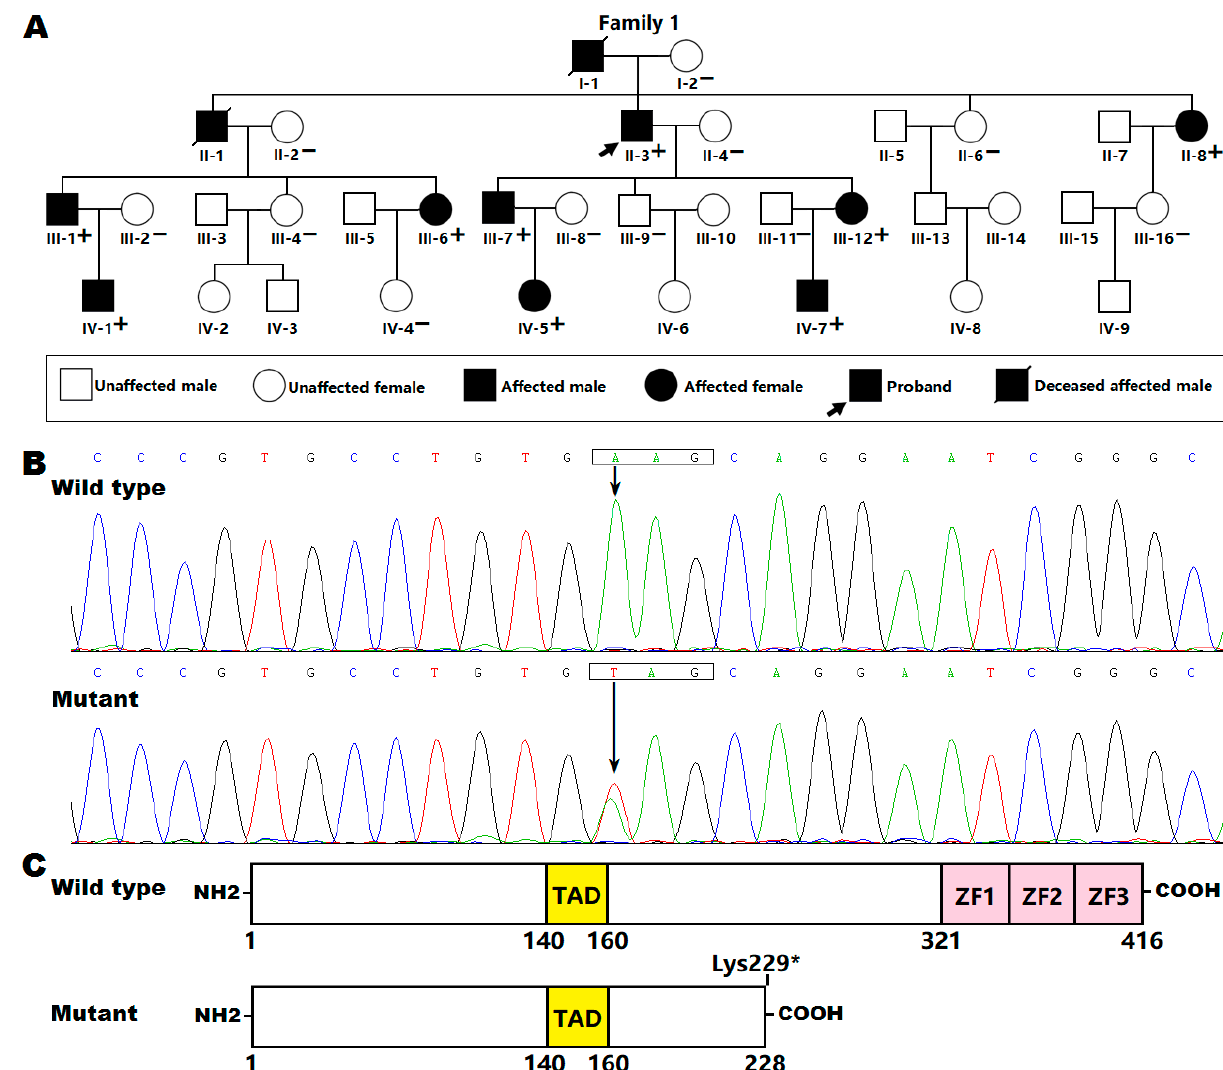
Figure 1. A novel KLF15 mutation responsible for familial atrial fibrillation. ( A ) Pedigree structure for the Chinese family with atrial fibrillation. The Chinese family was arbitrarily designated as family 1. Family members are identified by Roman-Arabic numerals. “+” indicates an individual carrying the heterozygous mutation; “–”, an individual with no mutation. ( B ) Sequence chromatograms showing the heterozygous KLF15 mutation and its wild-type control. An arrow symbol points to the heterozygous nucleotides of T/A in the proband (mutant) or the homozygous nucleotides of A/A in an unaffected individual (wild type). A rectangle marks 3 nucleotides comprising a codon of KLF15 . ( C ) Schematic diagrams of the structural domains of human KLF15 proteins displaying the mutation contributing to atrial fibrillation. COOH, carboxyl-terminus; NH2, amino-terminus; TAD, transcriptional activation domain; ZF, zinc finger.